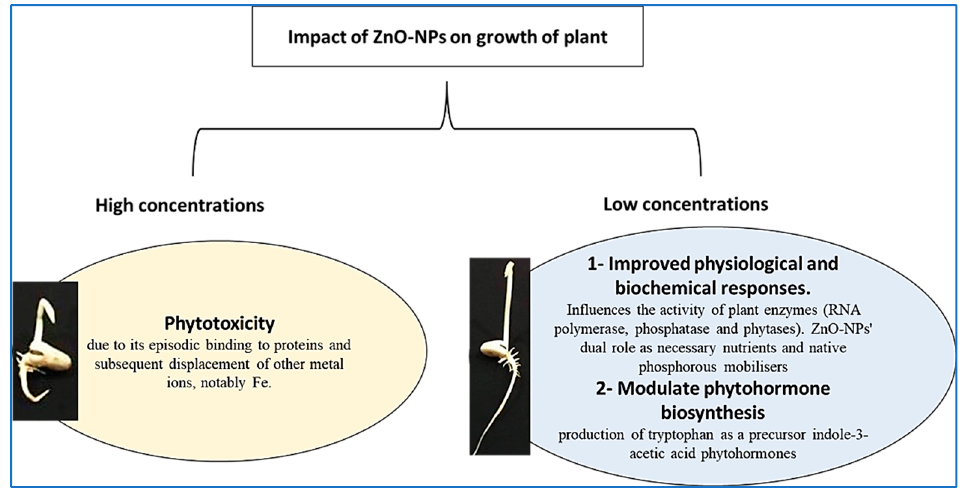
Figure 12. Schematic diagram of the effects of different concentrations of ZnO-NPs on plant growth.